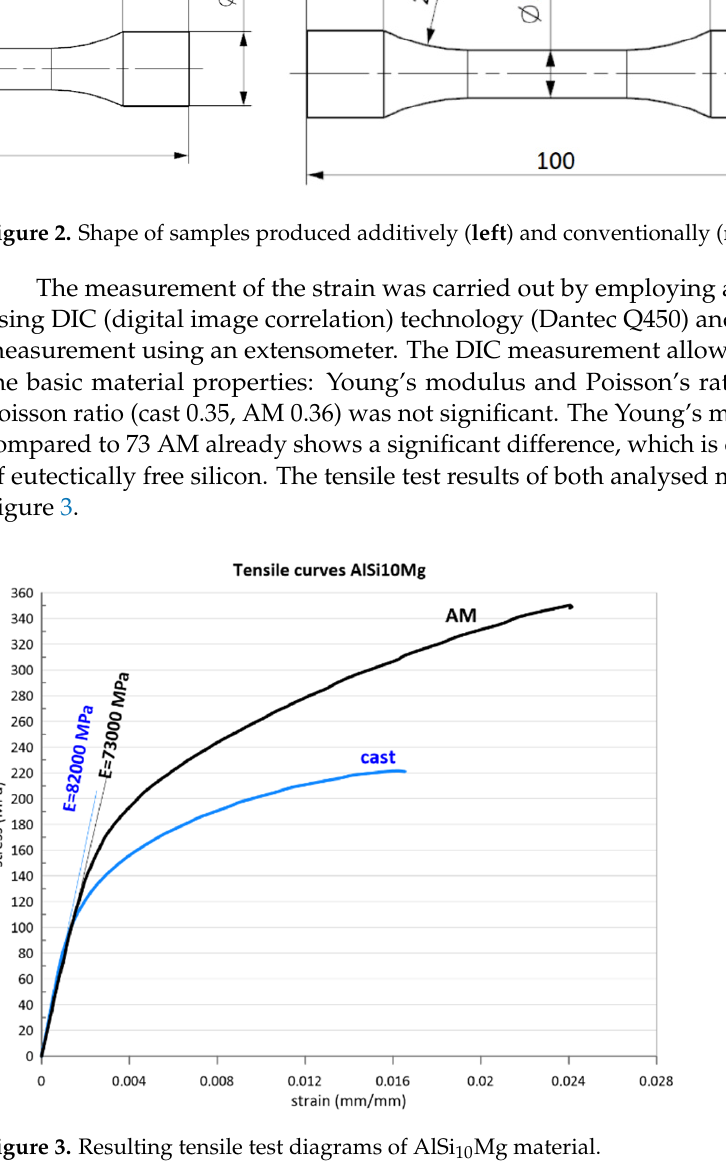
The e ff ect of the direction of cyclic loading versus the direction of deposition of the material layers was measured on two groups of specimens that di ff ered in the direction of printing (Figure 4).